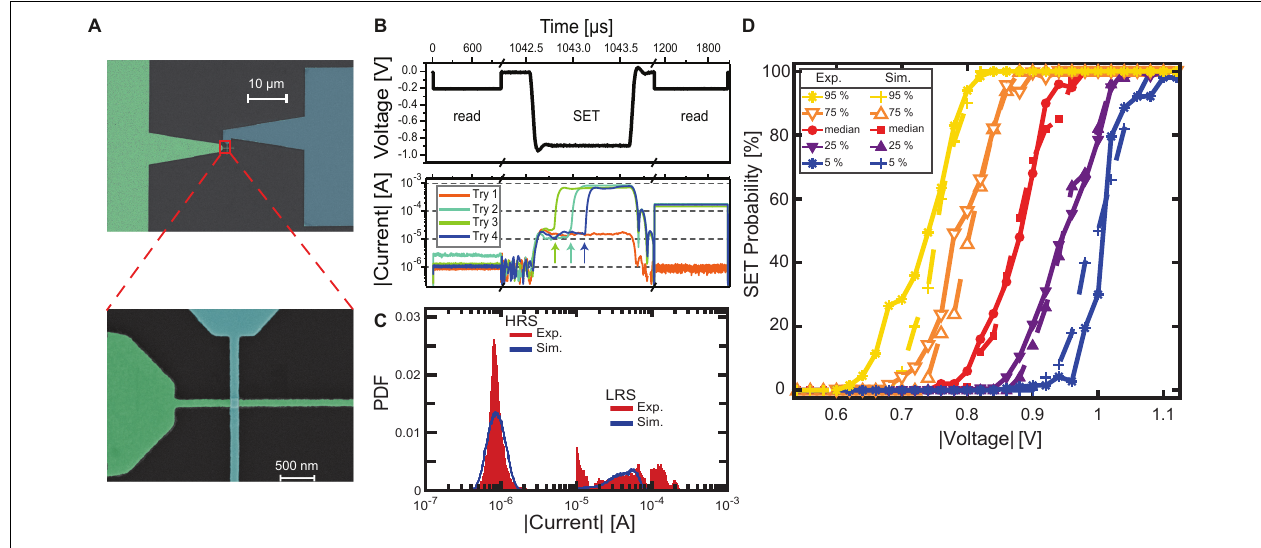
FIGURE 4 | SET switching variability for 1 µ s voltage stress time. (A) SEM picture of a single nano crossbar structure. Zoom-in to the device crossbar. (B) Shows a typical SET voltage stress sequence in the upper panel. A read pulse for verification of the HRS is followed by the voltage stress pulse. The resulting resistance state is detected by another read pulse. In the lower panel, possible current responses are shown in logarithmic scale. The SET transitions are indicated by the arrows. (C) Comparison of the read currents for HRS and LRS for simulation (blue lines) and experiment (red bars) by their respective probability density functions (PDF). (D) Statistics of the d2d variability for experiment and